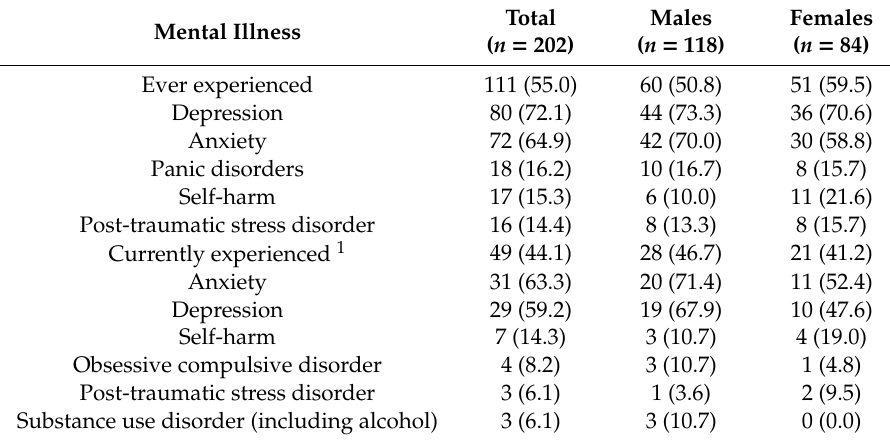
Table 4. Top five mental illness conditions experienced by coaches ( n and